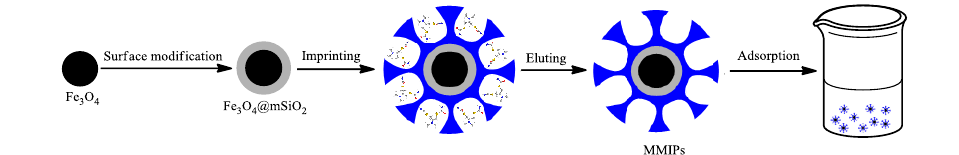
Figure 2. Schematics for the synthesis of Fe 3 O 4 @mSiO 2 @MIPs.